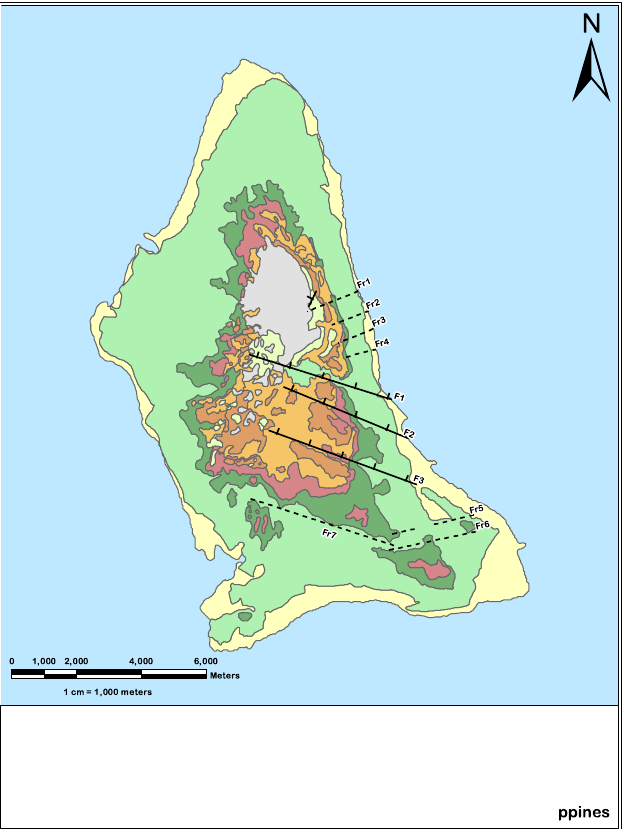
Figure 5. Geologic and Structural Geology Map, Bantayan Island, Cebu Province, Philippines [15].